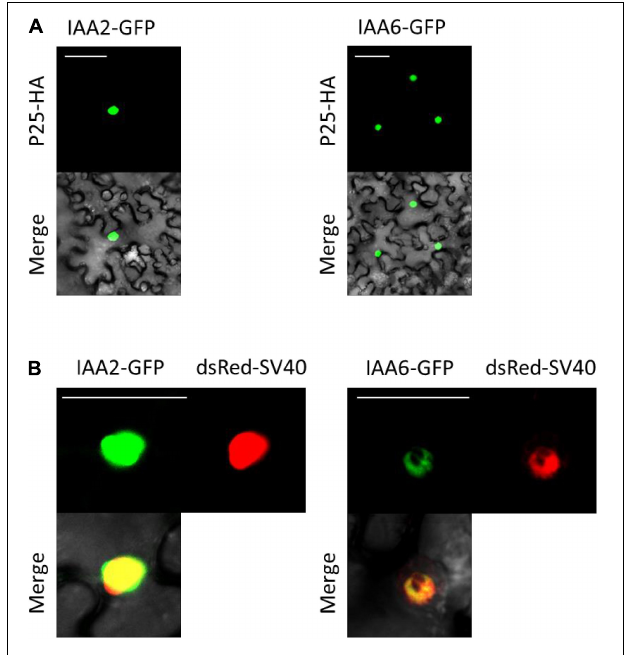
FIGURE 4 | Subcellular localization of interacting Aux/IAAs co-expressed with and without p25 (A) Co-infiltration of interacting partners p25 fused to an HA tag (p25-HA) together with IAA2 fused to GFP (IAA2-GFP) or IAA6 fused to GFP (IAA6-GFP). (B) Subcellular localization of IAA2-GFP and IAA6-GFP transiently expressed in N. benthamiana epidermal leaf cells. Both proteins were co-expressed with the nuclear marker dsRed-SV40. Images were taken at 4 dpi. Scale bars, 50 µ